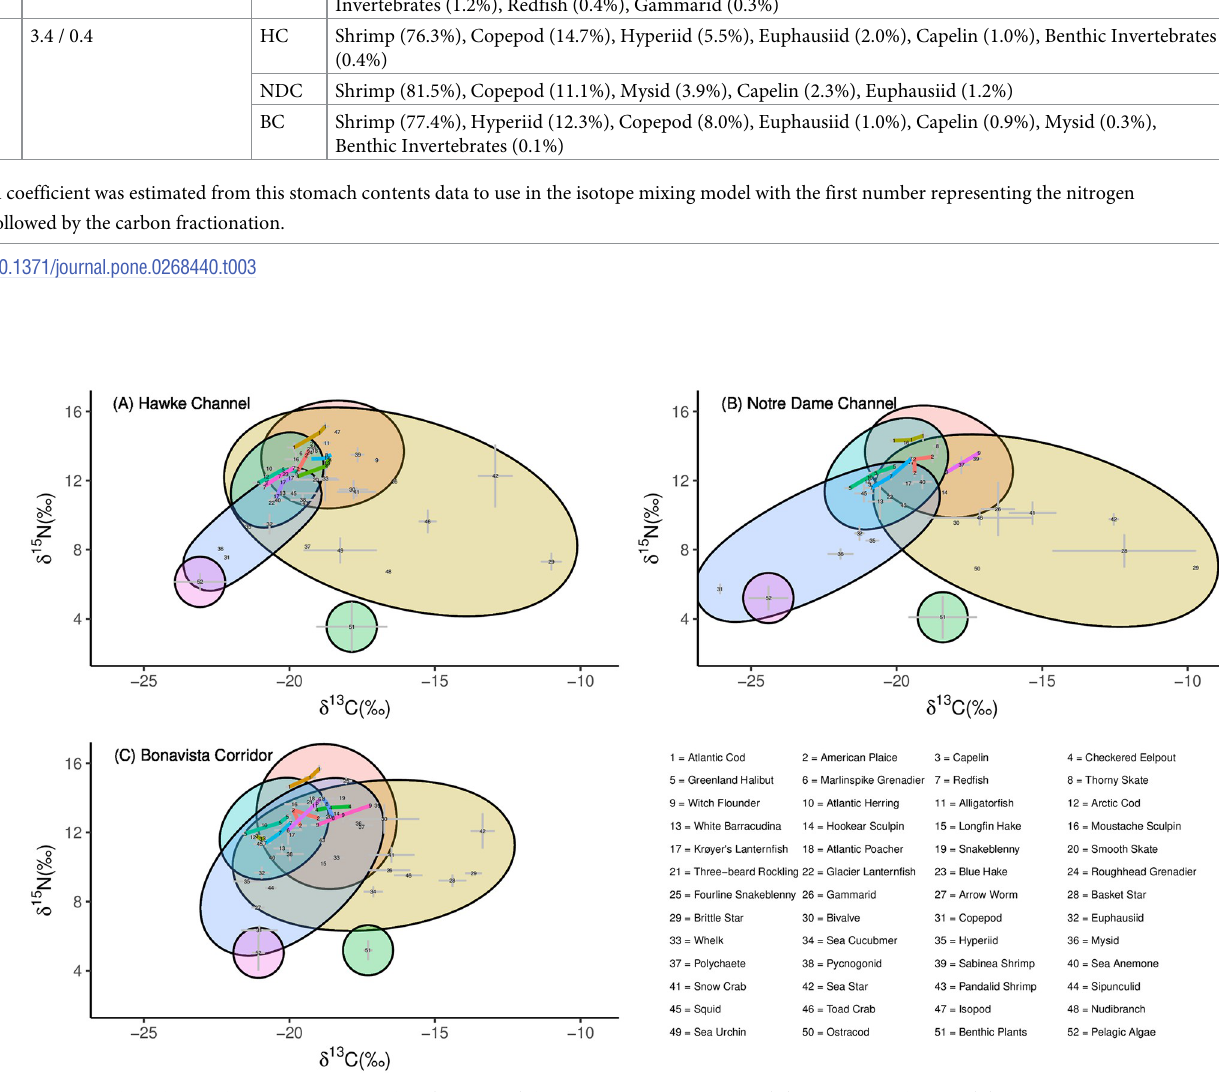
PLOS ONE | https://doi.org/10.1371/journal.pone.0268440 May 20,